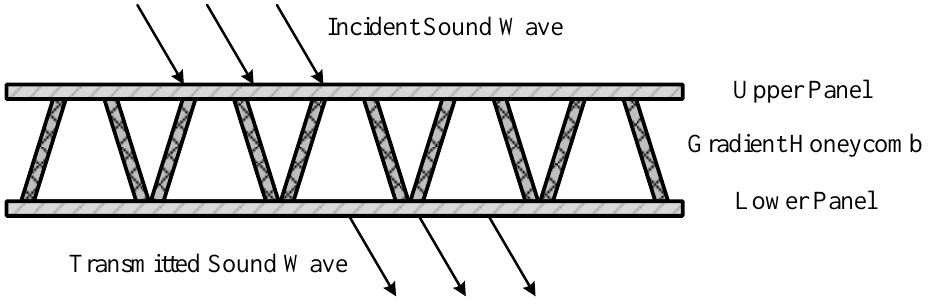
Figure 1. Gradient honeycomb sandwich panel.